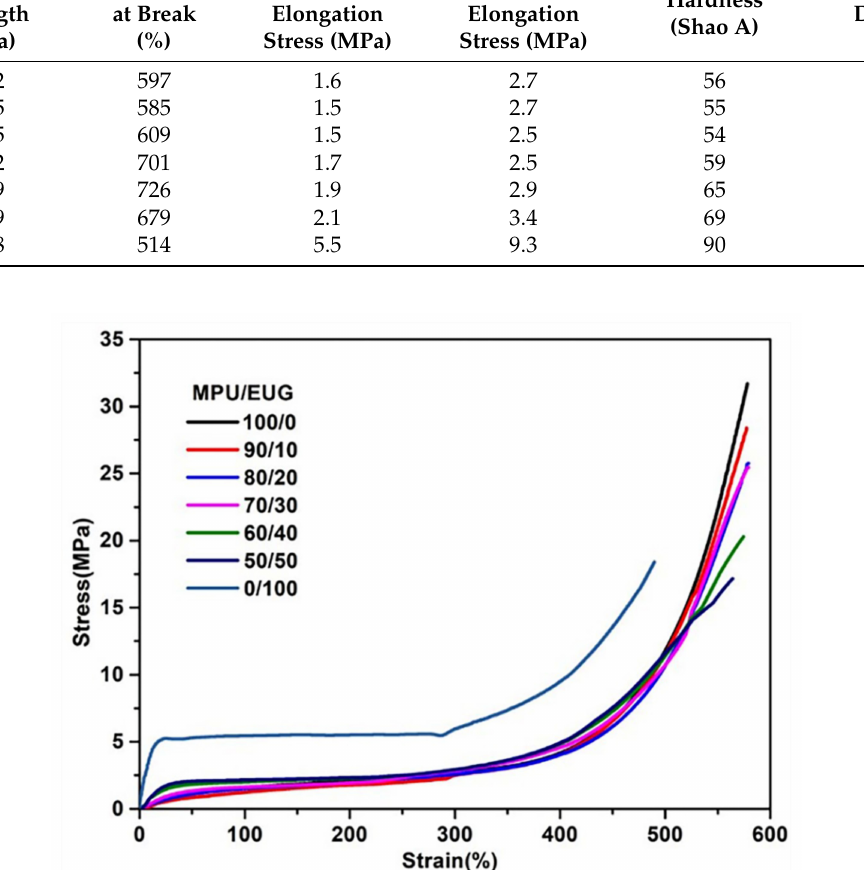
Figure 8. Stress–strain curves of various MPU/EUG